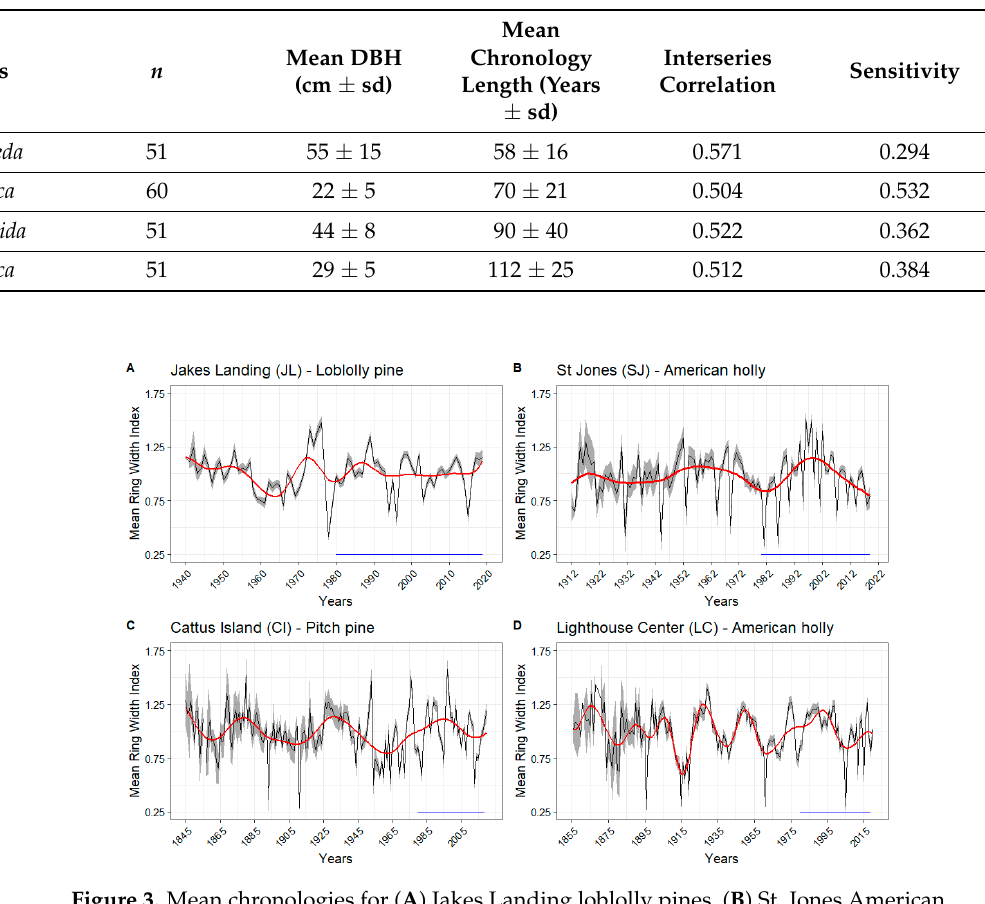
Table 2. Summaries of chronologies developed for each site, including site, species, number of cores ( n ), mean diameter at breast height (DBH, in cm ± standard deviation (sd)), mean chronology length (in years ± sd), interseries correlation, and sensitivity.